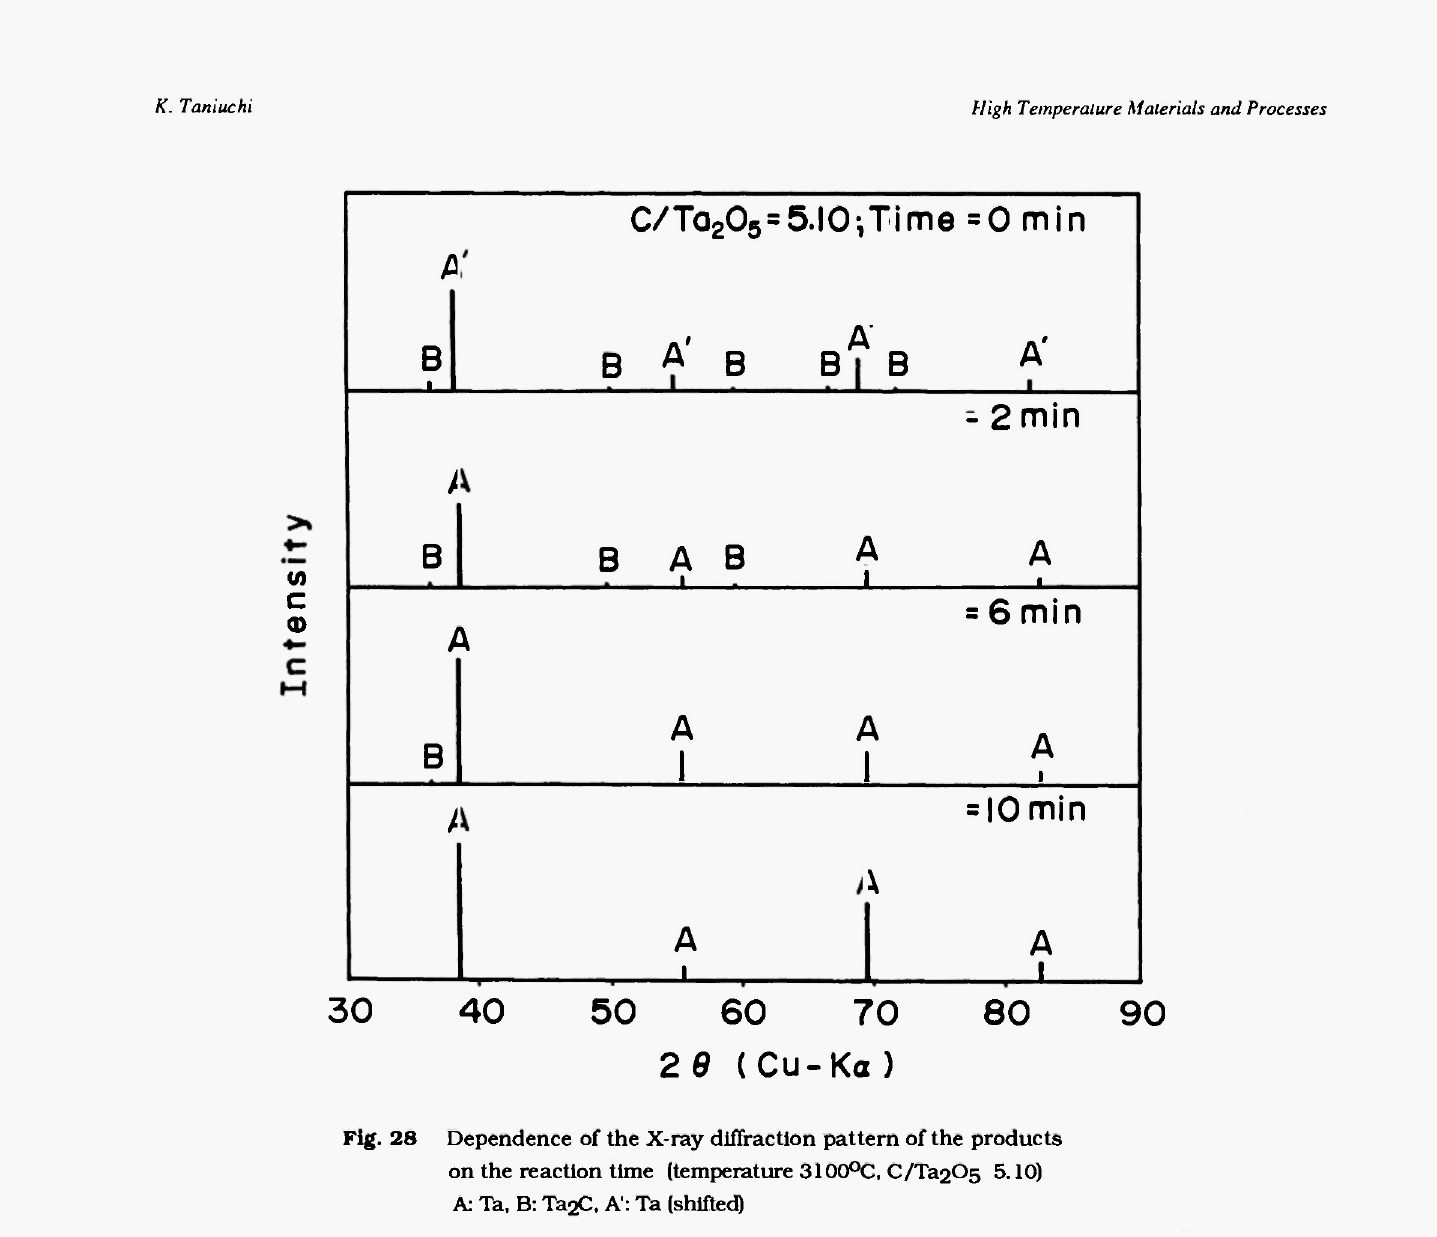
Fig. 28 Dependence of the X-ray diffraction pattern of the products on the reaction time (temperature 3100°C, C/Ta2C>5 5.10) A: Ta. B: Ta2C, A: Ta (shifted)